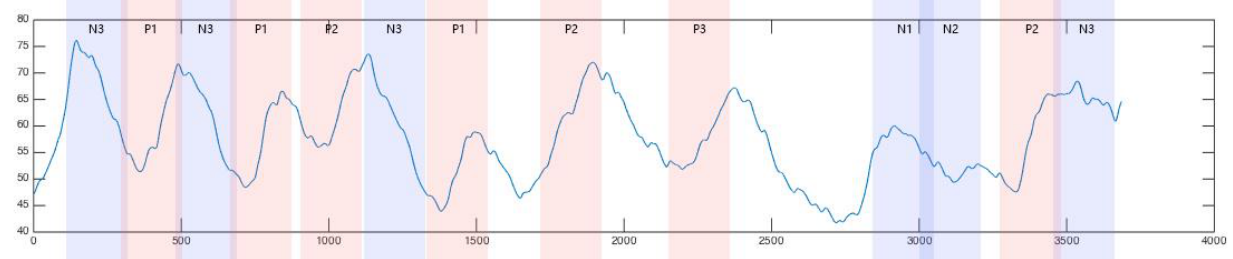
Figure 8. Segment cutting of skin electrical signal according to game events.